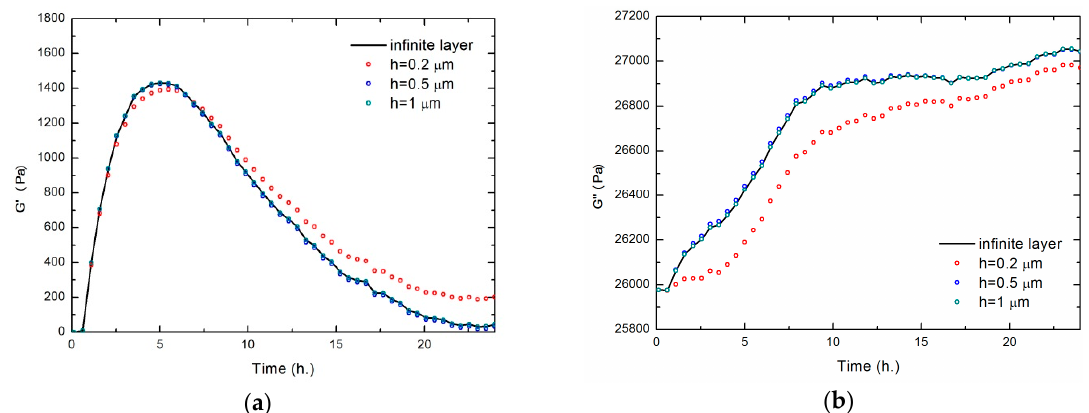
Figure 6. Influence of thickness, h, biofilm layer during its formation. Time curve of the real shear modulus, G' ( a ) and the imaginary shear modulus; G'' ( b ) at the frequency of 5 MHz. S. epidermidis ATCC 35984 producing strain.